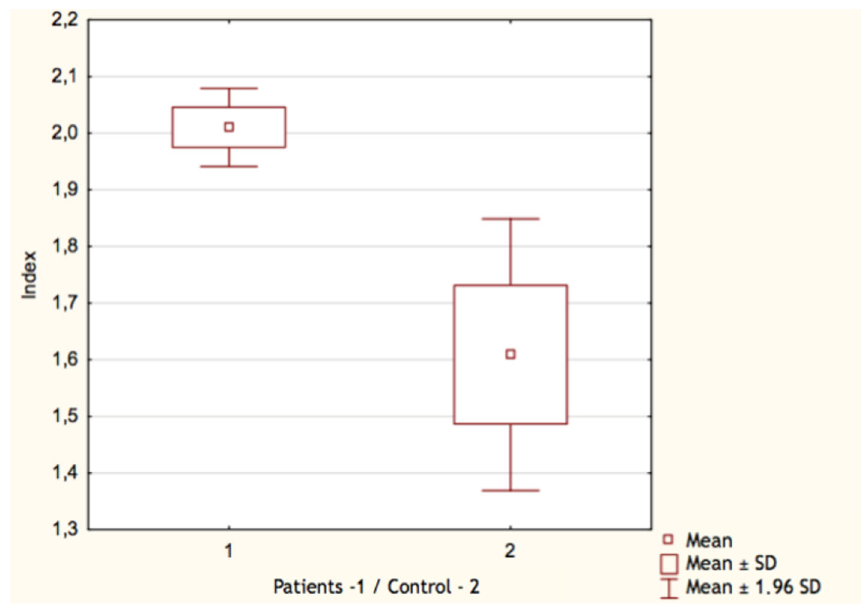
Figure 4. Index CD4+/CD8+ lymphocytes in patients (1) and control group (2).